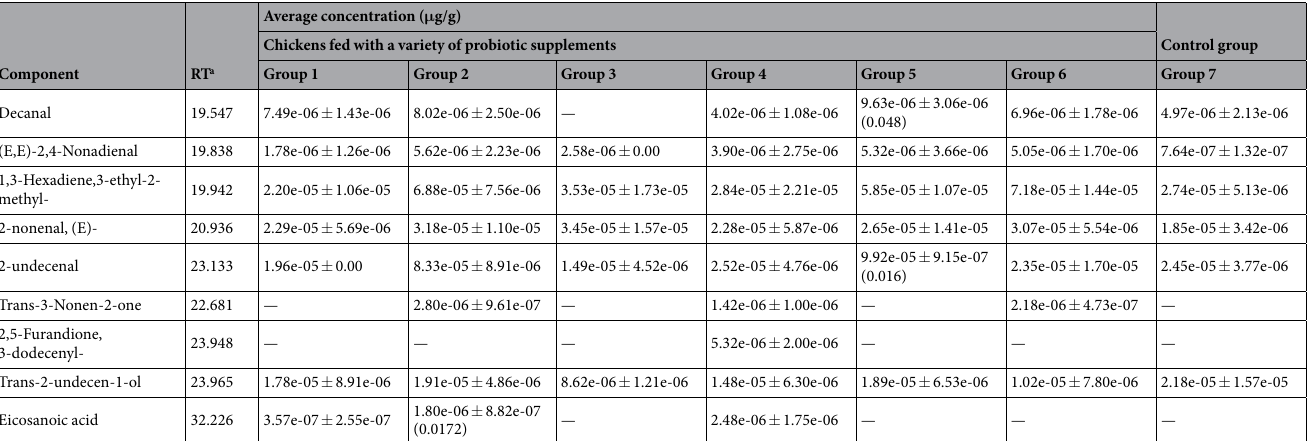
Table 2. Comparison of partial flavor components in breast meat of birds with and without probiotic additive. a RT means the retention time of each flavor component by HS-SPME-GC-MS analysis. The dash ( − ) represents the specific flavor compound was not detected from the sampled breast meat in a certain group. Figure in parentheses means the statistical significant difference P values of the concentration of certain flavor compound in chicken breast meat between certain treatment group and the control group Group 7.